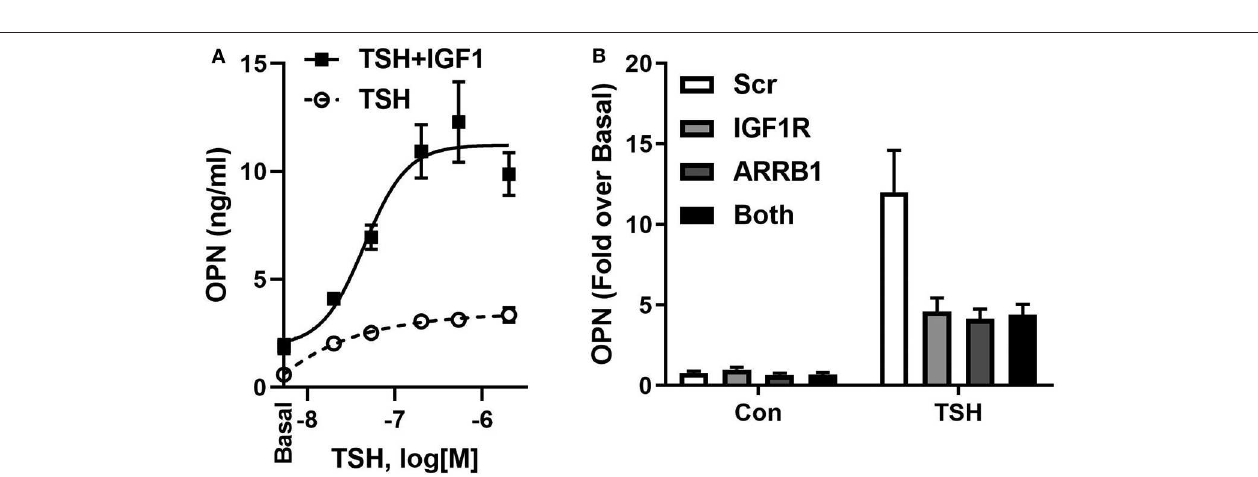
FIGURE 3 | TSHR and IGF1R exhibit crosstalk in U2OS-TSHR cells. (A) TSH and IGF1 synergistically stimulate OPN secretion. U2OS-TSHR cells were treated with increasing doses of recombinant human TSH (rhTSH) with or without 100ng/ml IGF1. After 5 days, OPN secreted into cell culture media was measured by ELISA. This original figure is based on the data published in ( 52). (B) IGF1R and β -arrestin 1 are part of the same signaling pathway in TSHR/IGF1R crosstalk-mediated OPN secretion. U2OS-TSHR cells, in which IGF1R and β -arrestin1 (ARRB1) were silenced separately or simultaneously were treated with 10 mU/ml rhTSH. After 5 days, OPN was measured in culture media and compared to scramble siRNA (Scr) control. Knockdown efficiencies of IGF1R and ARRB1 were 95.5 and 82.9%, respectively